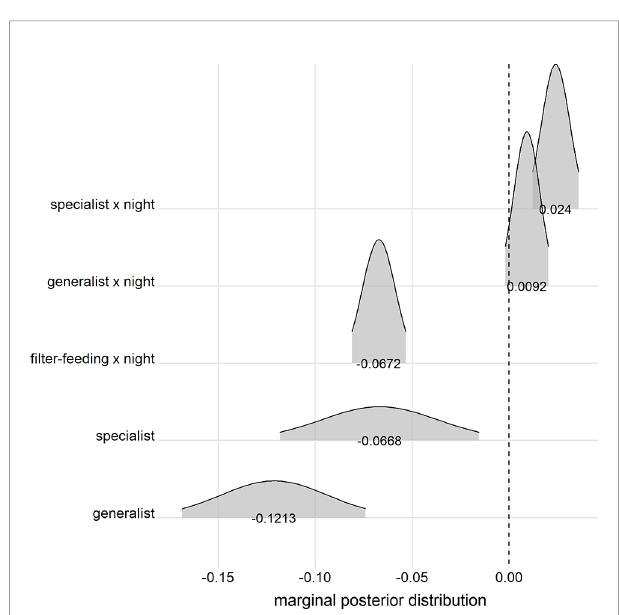
FIGURE 5 | Hierarchical cluster dendrogram depicting three groups of pelagic elasmobranch species (dashed rectangles) ordered by their similarities in relation to maximum diving depths. The shaded, colored rectangles represent groups of species which share the same feeding habit (i.e., fi lter- feeding, specialist, and